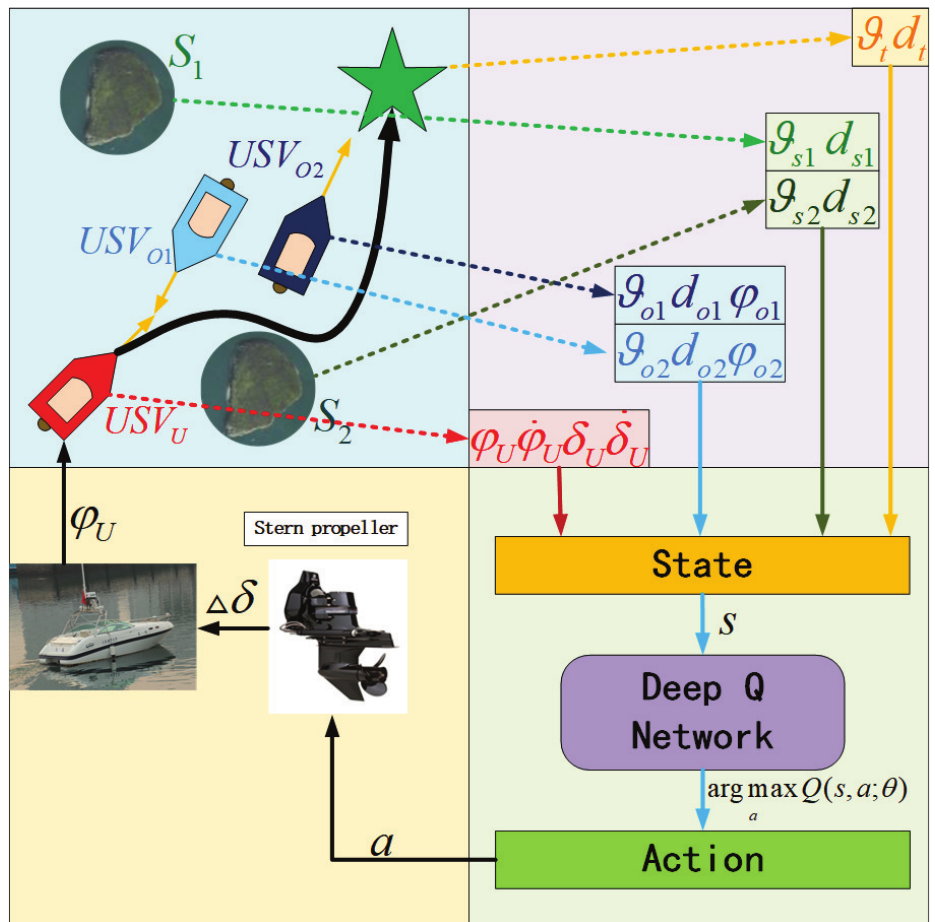
Figure 5. Training